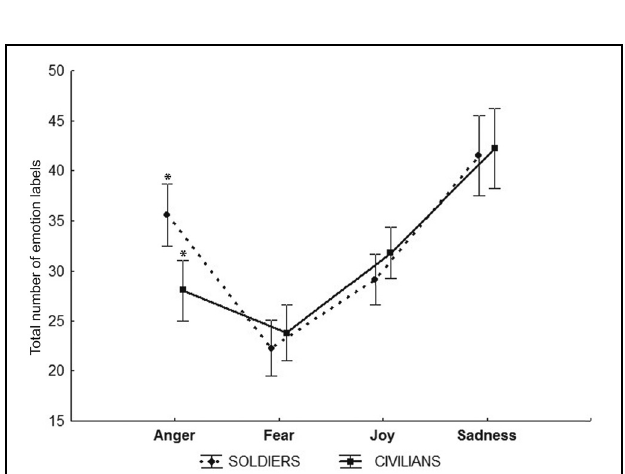
FIGURE 5 | Errors analyses for each emotion. Plots show the results of the analyses of errors made by each subjects of both groups performed for each emotion with four separate ANOVAs. The number of incorrect uses of